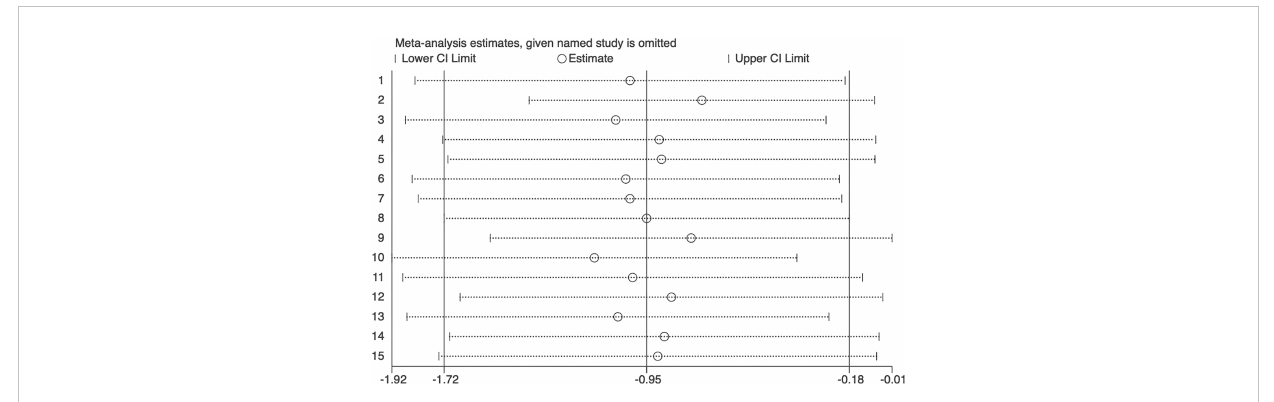
FIGURE 5 Sensitivity analysis plot of circulating omentin levels between MAFLD and healthy control group. Sensitivity analysis showed robustness of the outcomes and no single study overin fl uenced the